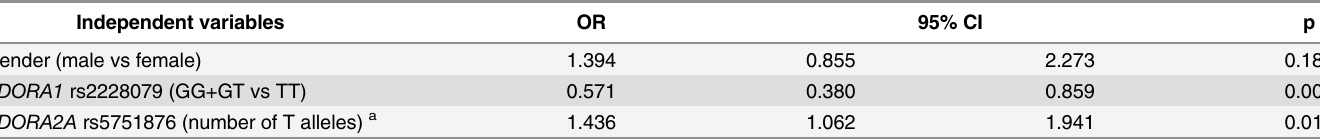
Table 2. Multivariate logistic regression analysis of independent factors associated with presence of GTS as dependent variable (GTS patients vs controls) Independent